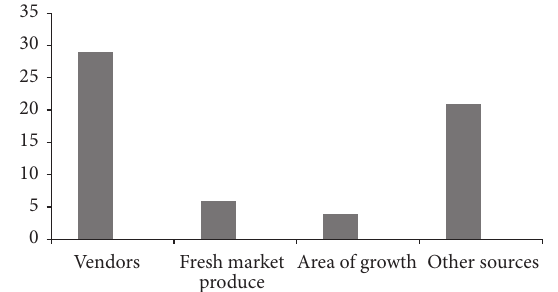
Figure 4: Sources of D. steriscus for Bindura high density suburbs residents. Table 4: (a) Selling of D. steriscus and its availability ( 𝑁 = 30 ). (b) Availability of D. steriscus tuber in Bindura local market.